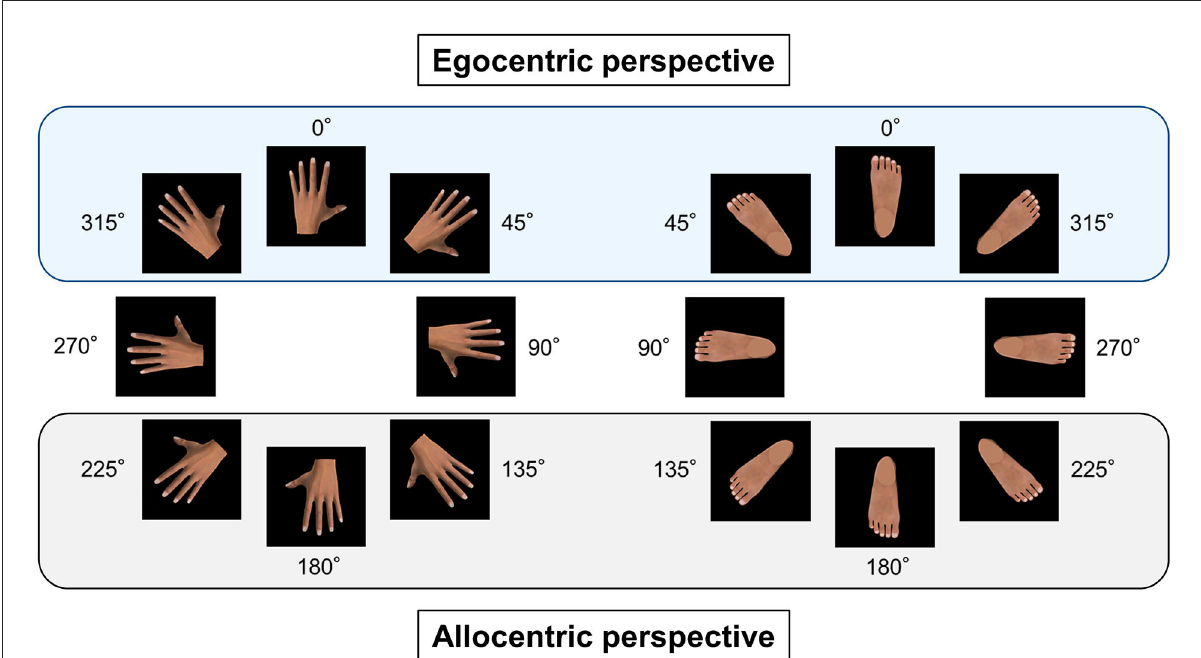
FIGURE1 Egocentric and allocentric perspectives of body part images. The left body part images, such as the dorsal hand images, were rotated clockwise, whereas the right body part images, such as the dorsal foot images, were rotated counterclockwise in 45 ◦ increments. The visual stimuli were displayed in eight different angular disparities of 0 ◦ (upright position), 45 ◦ , 90 ◦ , 135 ◦ , 180 ◦ , 225 ◦ , 270 ◦ , and 315 ◦ . The egocentric perspective was comprised of three image orientations: 0 ◦ , 45 ◦ , and 315 ◦ , and the allocentric perspective was comprised of three image orientations: 135 ◦ , 180 ◦ , and 225 ◦